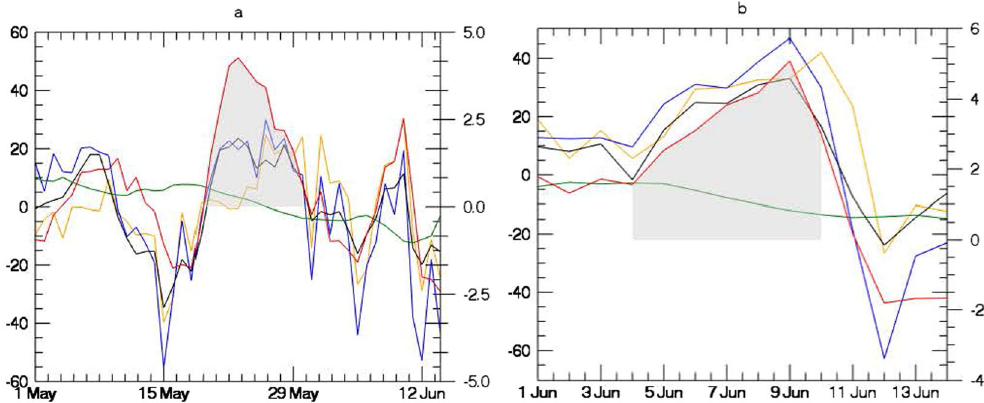
Figure 4. Average daily anomaly based on 1980–2015 daily climatology for a) COHW May and for ( b ) COHW June over Indian landmasses. The y axis scale on the right indicates SAT (°C, red line). The y axis on the left indicates sensible heat flux (W m − 2 , orange line), net SW radiation (W m − 2 , blue line), net LW radiation (W m − 2 , black line) and total profile soil moisture (mm, green line). Net LW radiation has been plotted with the reversed sign. Grey color shows the anomalously positive SAT during two extreme heat events during May and June. Data visualizations produced using IDL [8.4] (Exelis Visual Information Solutions, Boulder,